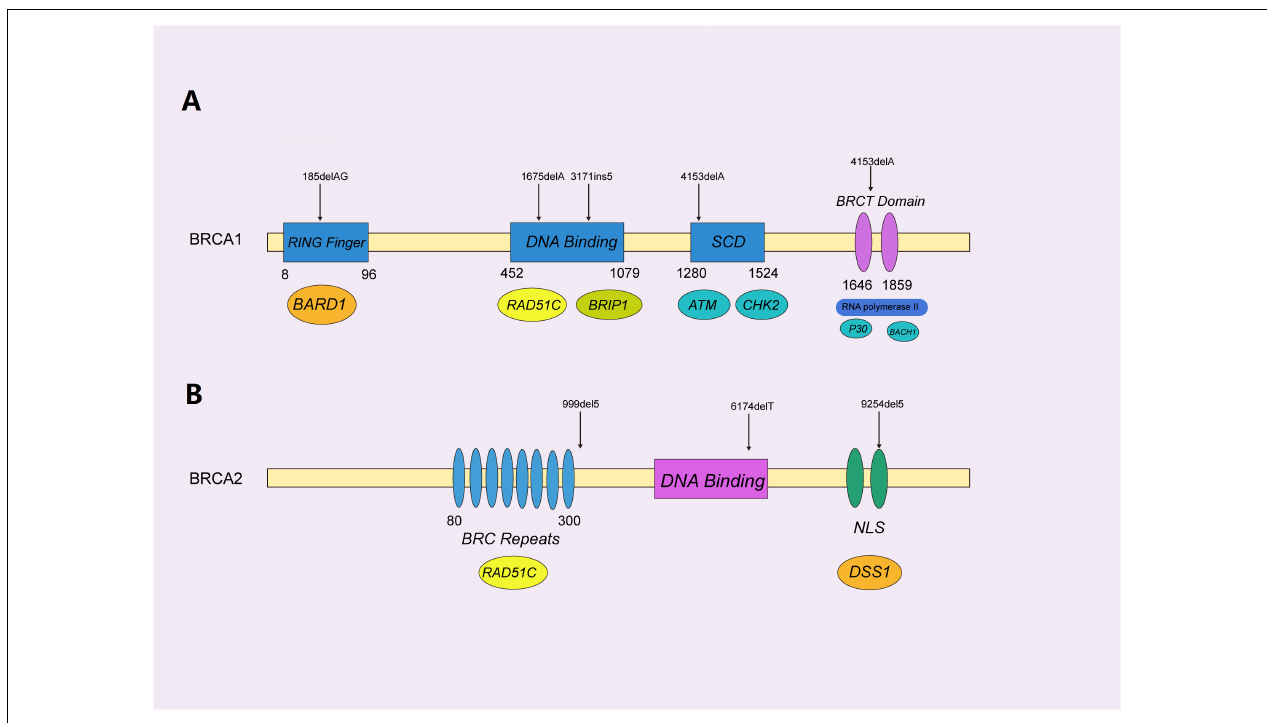
FIGURE 3 | Functional domains of BRCA1/2 protein with pathogenic mutations. (A) The functional domains of the BRCA1 protein, mainly containing the RING-finger, SQ-cluster, and BRCT (middle) domains, functionally interacted with BARD1, RAD51C, and ATM (beneath), to orchestrate homologous recombination. The selected reported pathogenic mutations are indicated with black arrows, as shown. (B) BRCA2 was represented by a similar schematic figure with different functional domains (middle) and binding partners (beneath); confirmed pathogenic mutations are also shown